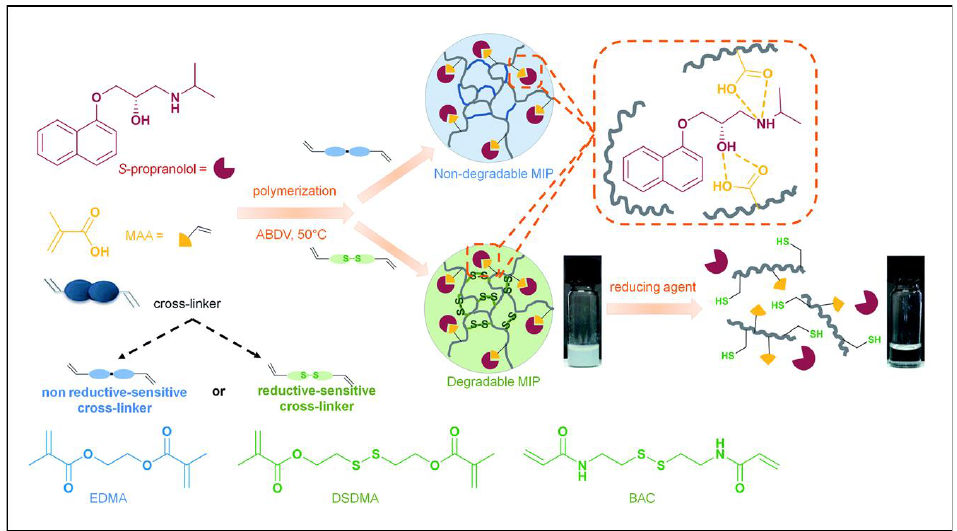
Figure 8. Schematic representation of syntheses and reduction-induced degradation of S-propranolol molecularly imprinted polymers for drug delivery. Reprinted with permission from Ref. [113].